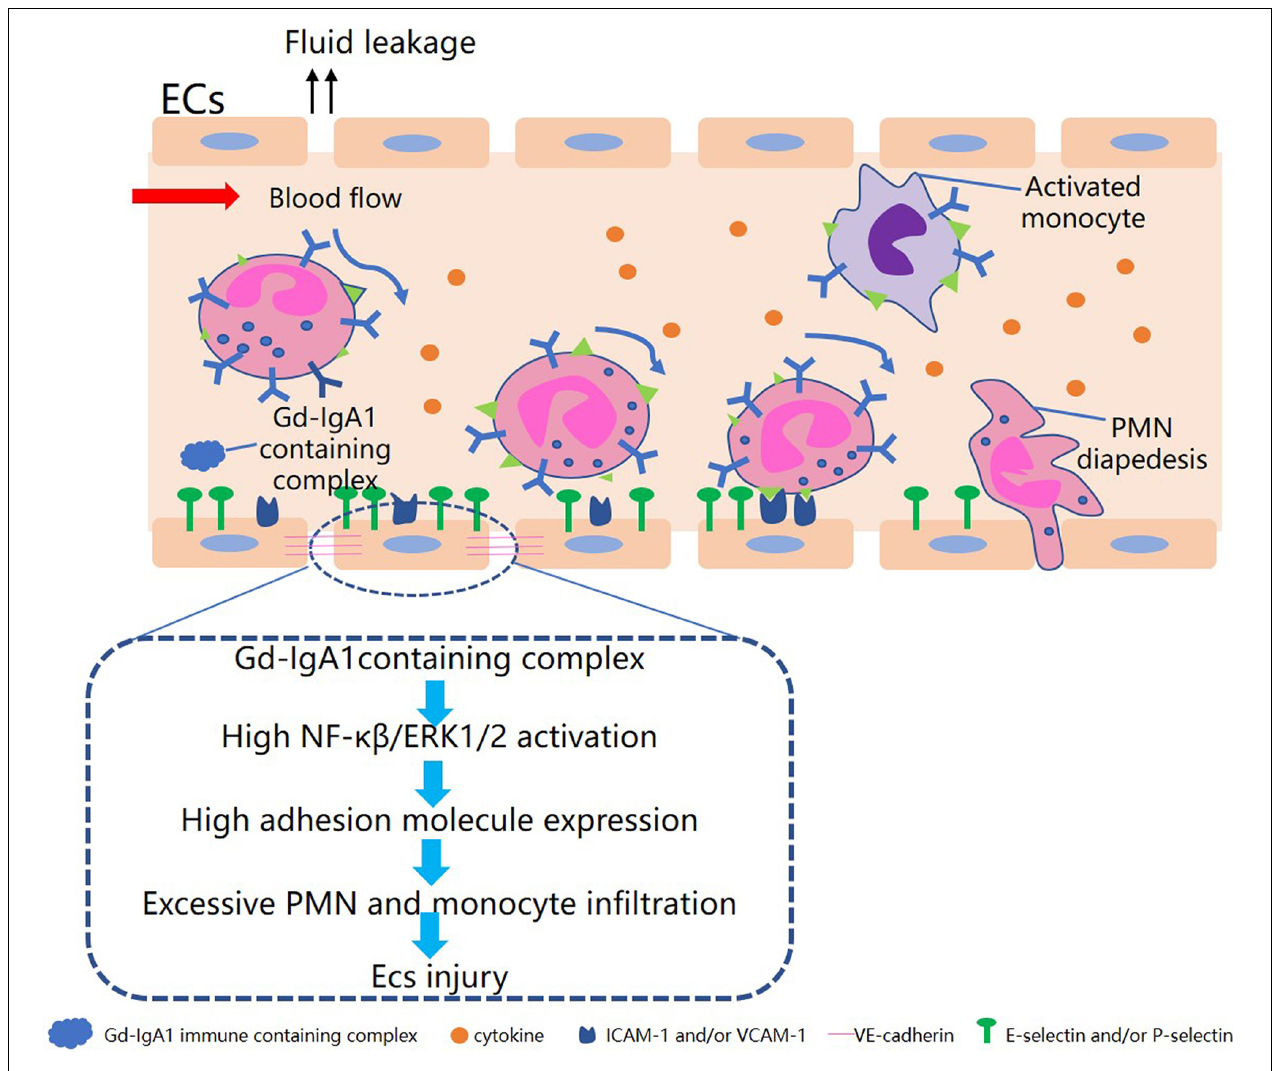
FIGURE 1 | Diagram of Gd-IgA1-containing complex in relation to endothelial cell injury in